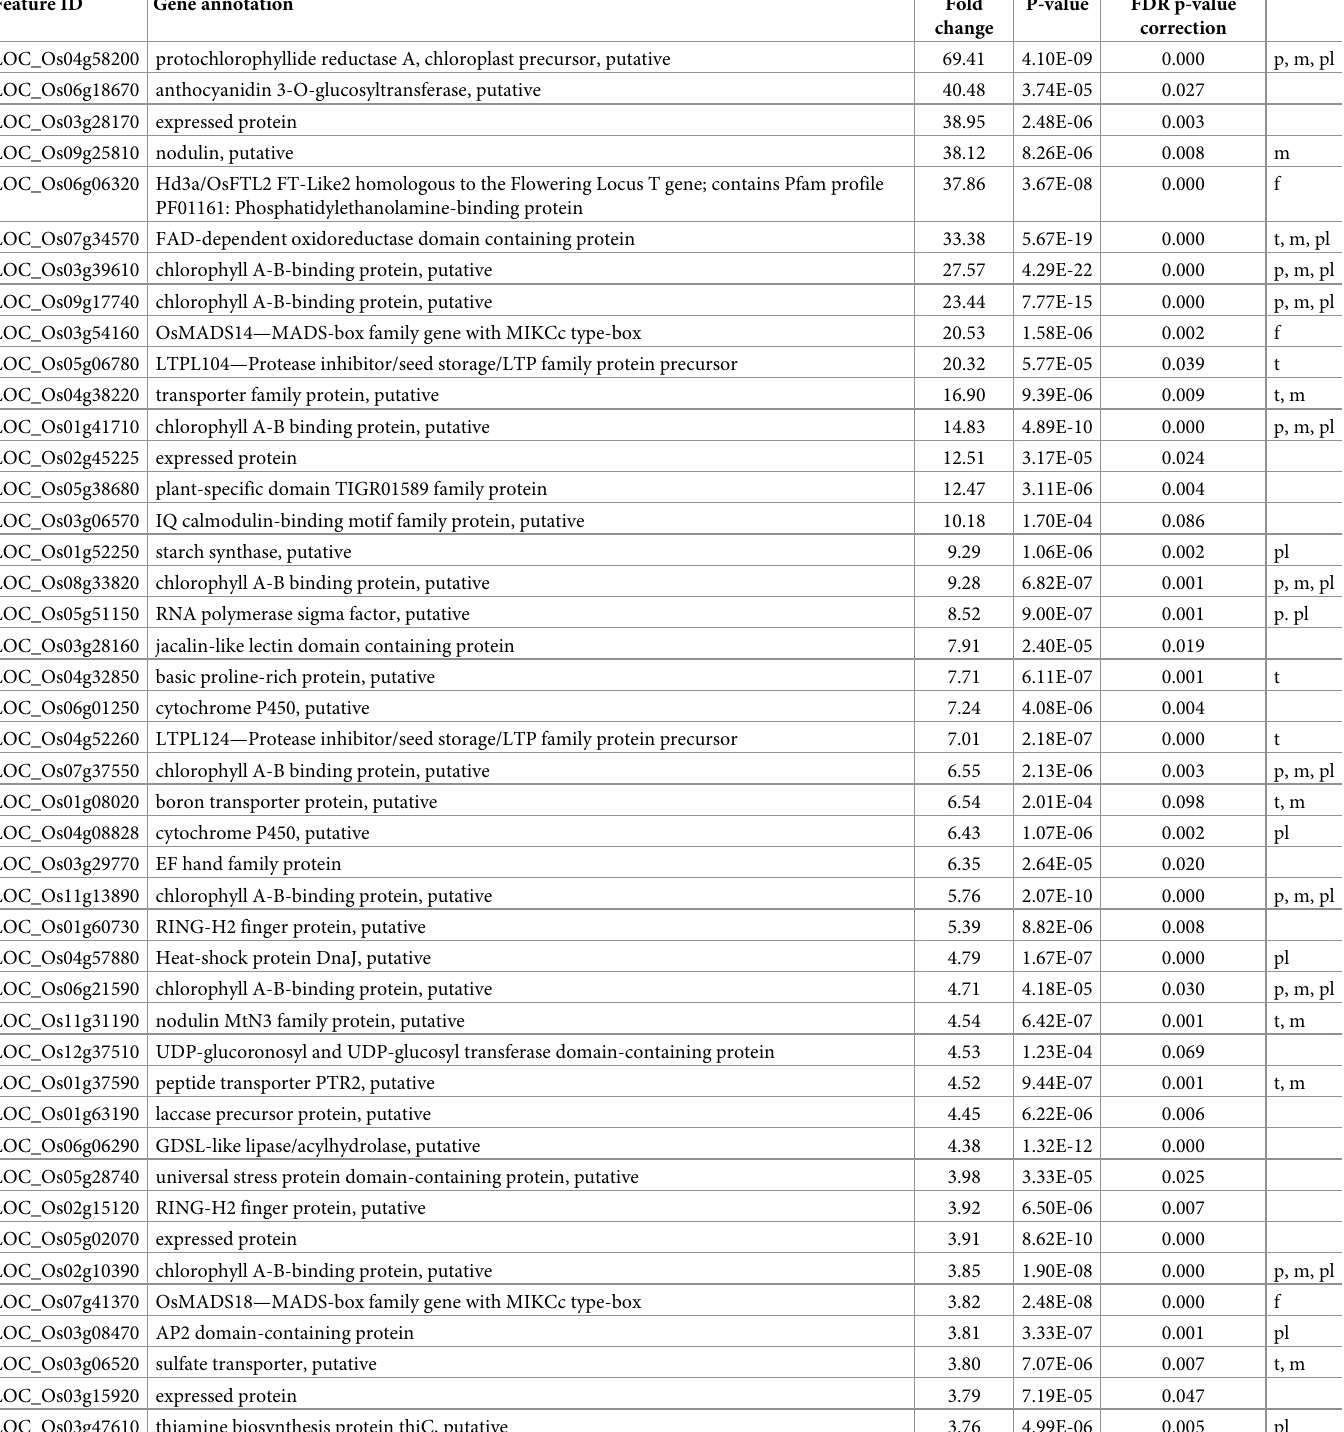
Table 2. List of the differential expressed genes between Gleva and G123 . The tagwise dispersions using the EDGE test for fold change, p-value and FDR p-value correc- tion are shown. Genes included in different classification groups are indicated as: (f) flowering, (t) transport, (p) photosynthesis, light harvesting, and responses to blue, red and far red light, (m) membrane, (pl) plastid and chloroplast and (c) cytoplasm components. Feature